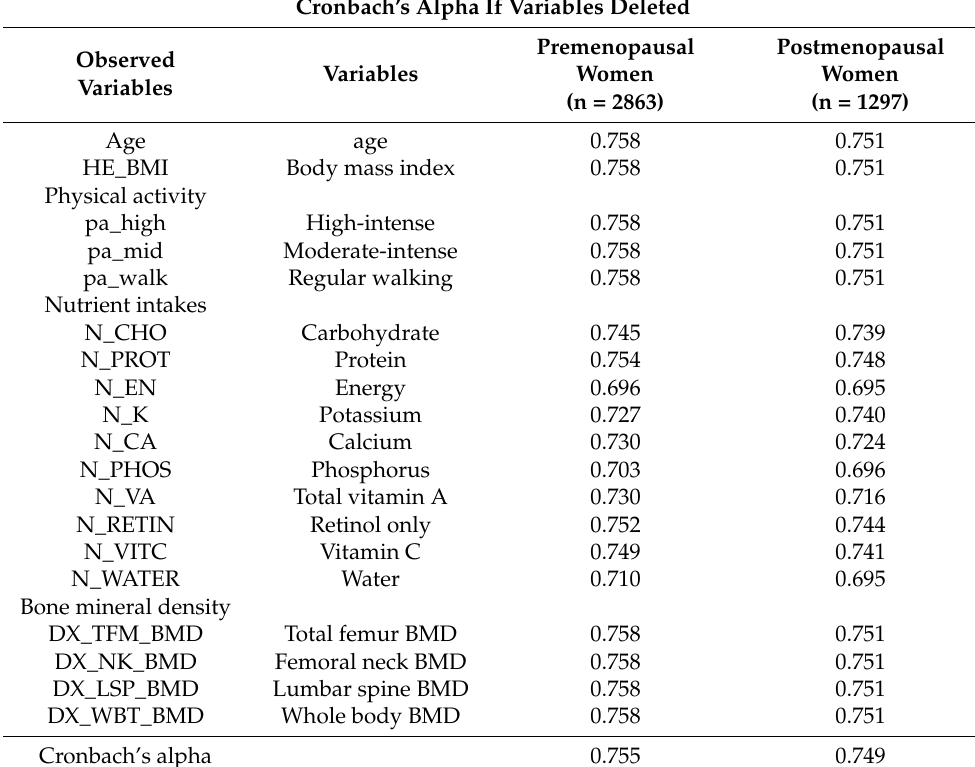
Table 2. Variable selection with Cronbach’s α .